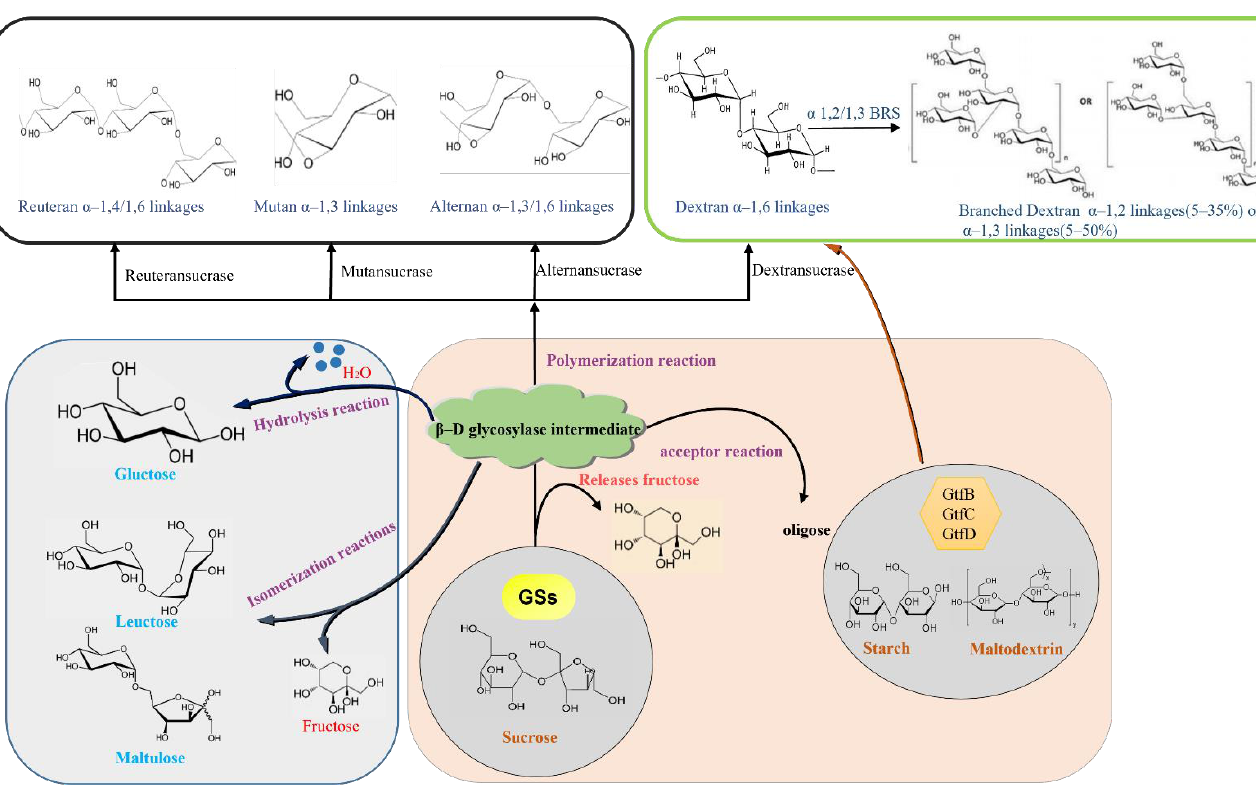
Figure 3. GSs catalytic reaction mechanism.